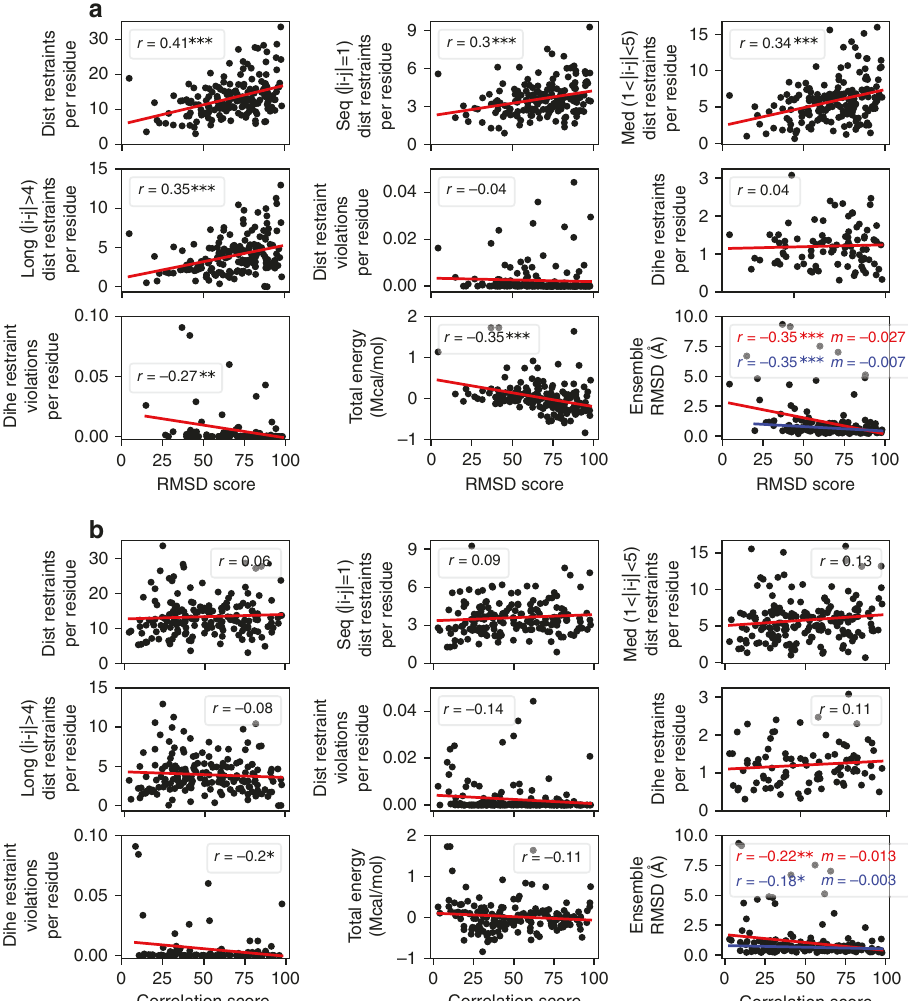
Fig. 4 Correlations between conventional NMR-based predictors of accuracy and ANSURR scores. a RMSD score, b correlation score. For each plot, the line of best fi t and the Pearson correlation coef fi cient are shown. For the comparisons with ensemble RMSD, fi ts are shown for all points (red) and for only those points with an ensemble RMSD ≤ 2.5 Å (blue). The statistical signi fi cance of the correlation coef fi cient is indicated by *** p < 0.001 ** p < 0.01, and * p < 0.05, determined using a two-tailed Pearson test. p values are (by row, left to right) a 3 × 10 − 8 , 7 × 10 − 5 , 6 × 10 − 6 , 3 × 10 − 6 , 0.56, 0.70, 9 × 10 − 3 , 2 × 10 − 6 , 2 × 10 − 6 (red), 5 × 10 − 6 (blue) and b 0.43, 0.22, 0.09, 0.32, 0.07, 0.30, 0.047, 0.13, 4 × 10 − 3 (red), 0.02